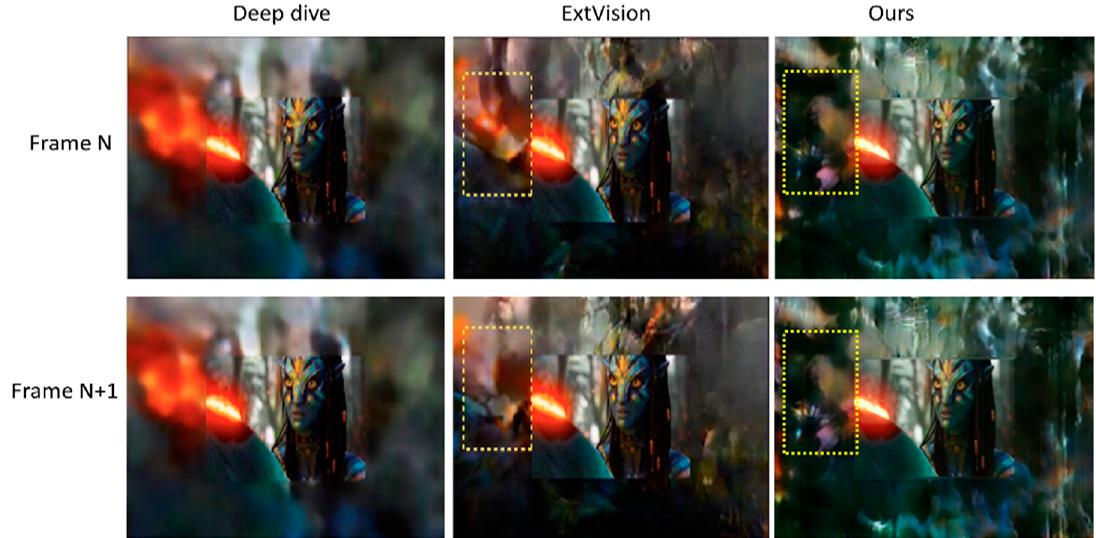
Figure 10. The comparison of the PCE testing result with the ExtVision and Deep dive research in the same way as reported in ExtVision.